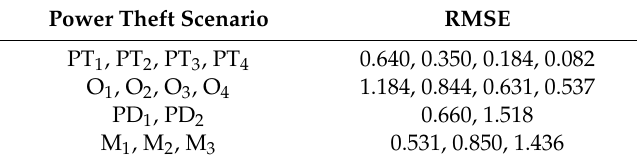
Table 5. Root mean square error (RMSE) calculated for the ANFIS training stage.